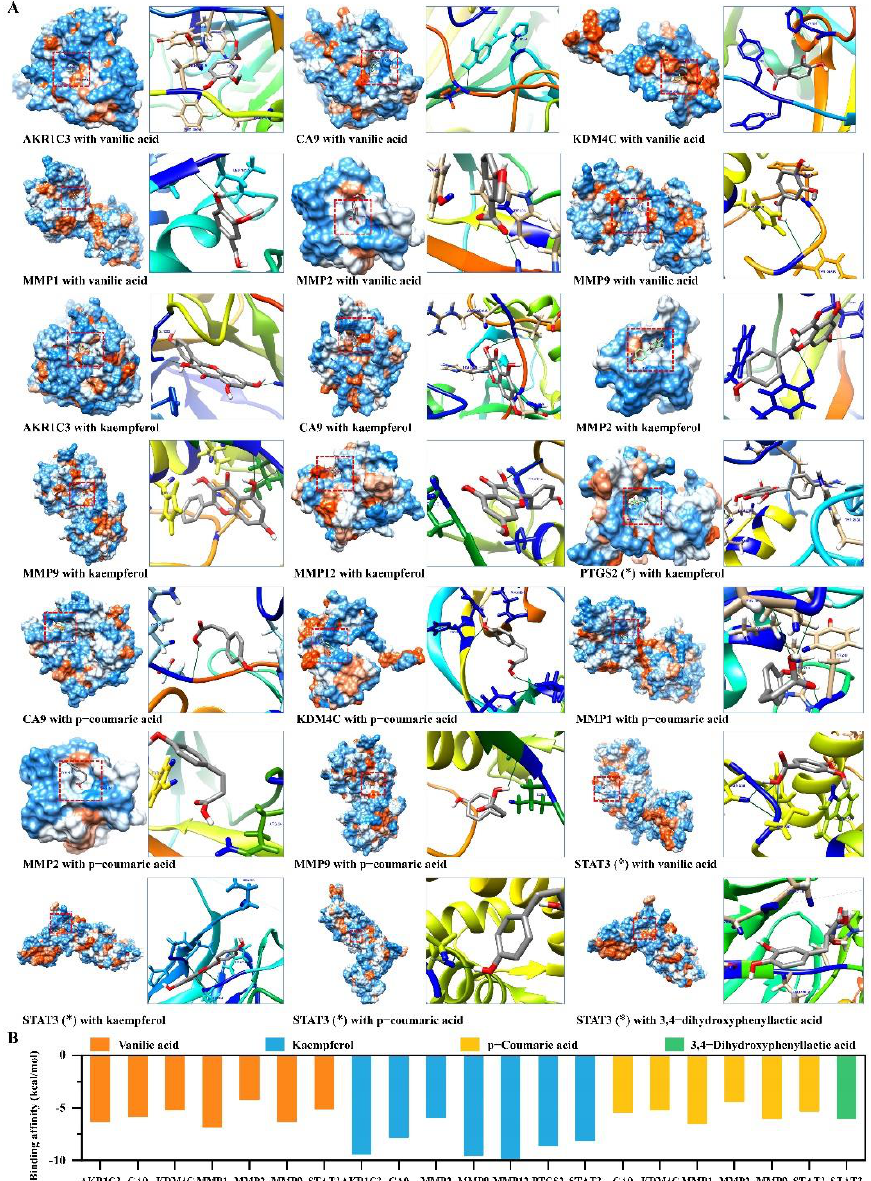
Figure 7. The main active components of SYF interact with candidate target proteins. ( A ) The binding action and binding site of the compounds to their targets. Amino acid residues that hydrogen bond to the compound were marked in blue. * Only part of the amino acid structure of the binding region of PTGS2 or STAT3 is displayed due to the molecular weight of the protein exceeding the calculation limit of the software. ( B ) The results of the binding affinity between the compounds and their targets.